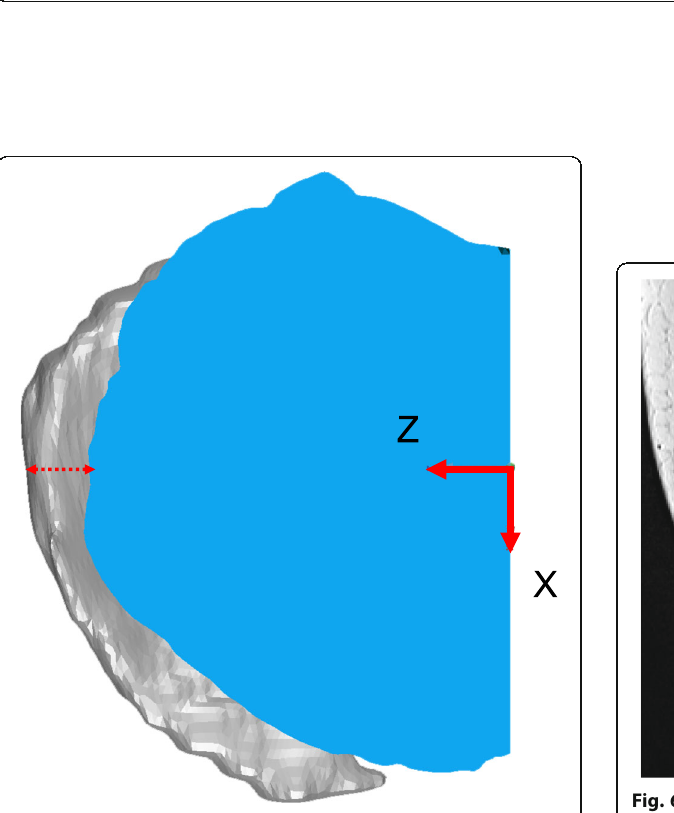
Fig. 4 Volume of the medial meniscal extrusion (MME) model. The medial meniscus (MM) is shown in gray color. a The MM (gray) and the medial tibial plateau model (blue). b The MM (gray) and the cross-sectional model of the medial tibial plateau (blue). c MME model (gray) and the thickened cross-sectional model. The MME volume is defined as the volume of the MM model outside the thickened cross-sectional model